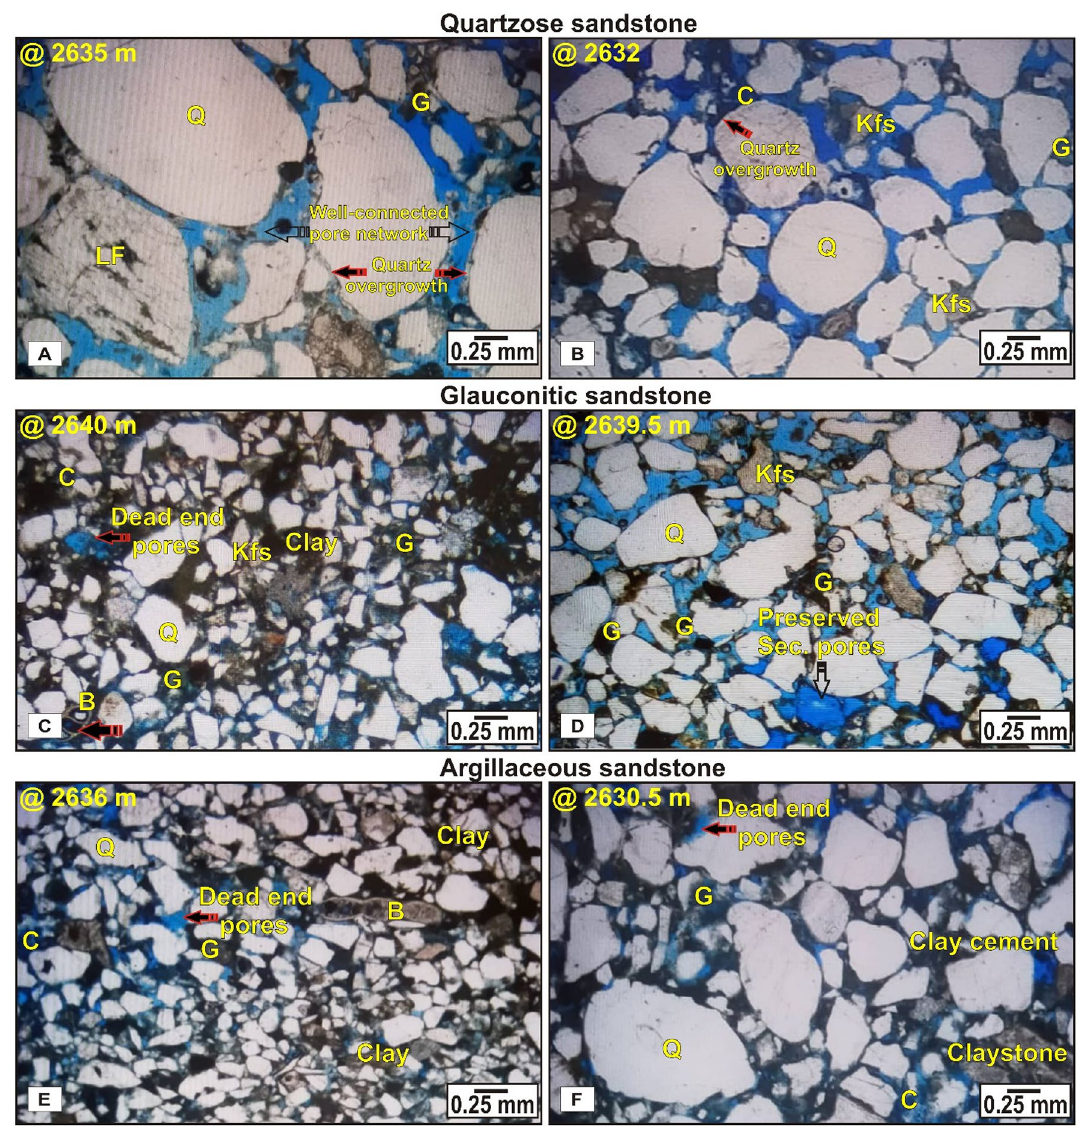
Fig. 9 Thin section microphotographs illustrating the different sandstones microfacies. Mineral symbols, quartz (Q), K-feldspar (Kfs), lithic fragments (LF), glauconite (G), bioclasts (B), calcite (C), and secondary pores (Sec.